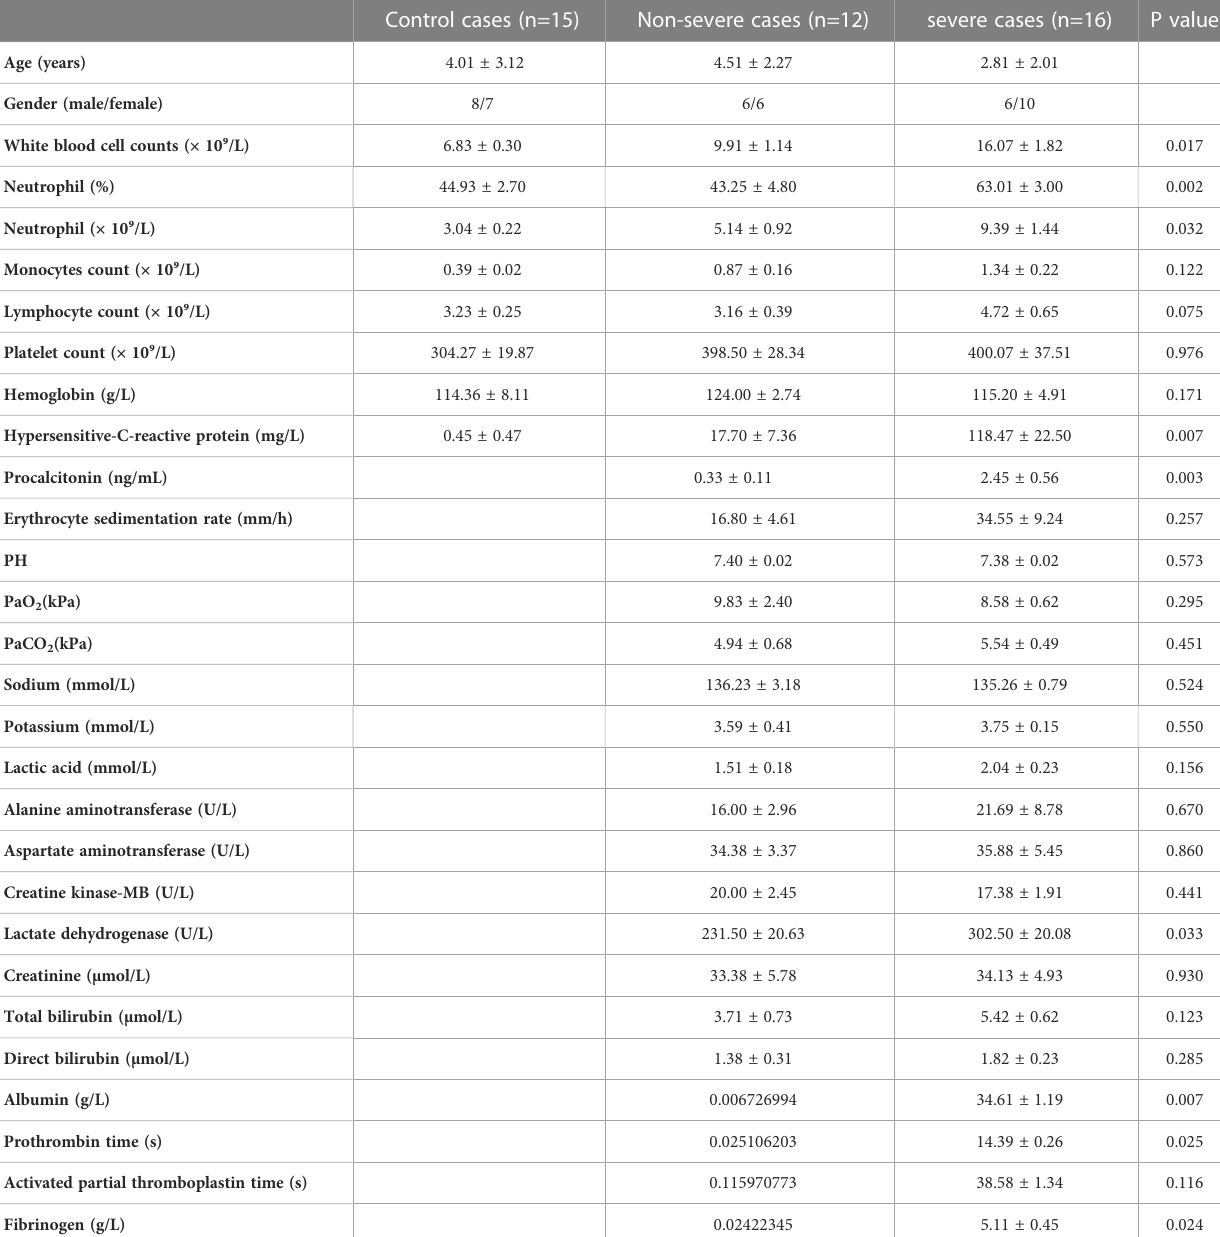
TABLE 1 Summary of clinical features and laboratory results of adenovirus pneumonia pediatric